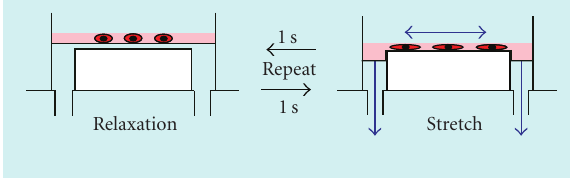
Figure 1: Stretching force was added continued for 1 hour at the cycle of 18% elongation for 1 second followed by 1-second